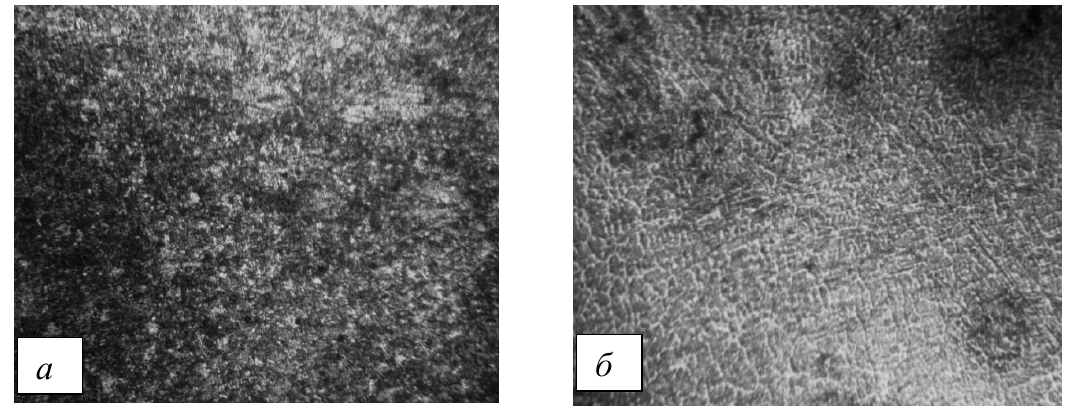
Fig.6. Microstructures of the deposited coating system Fe-Cr-Mo-V-C - 10% chromium, 1% molybdenum, 1% vanadium, 0.8% carbon, thickness up to 0.5 mm